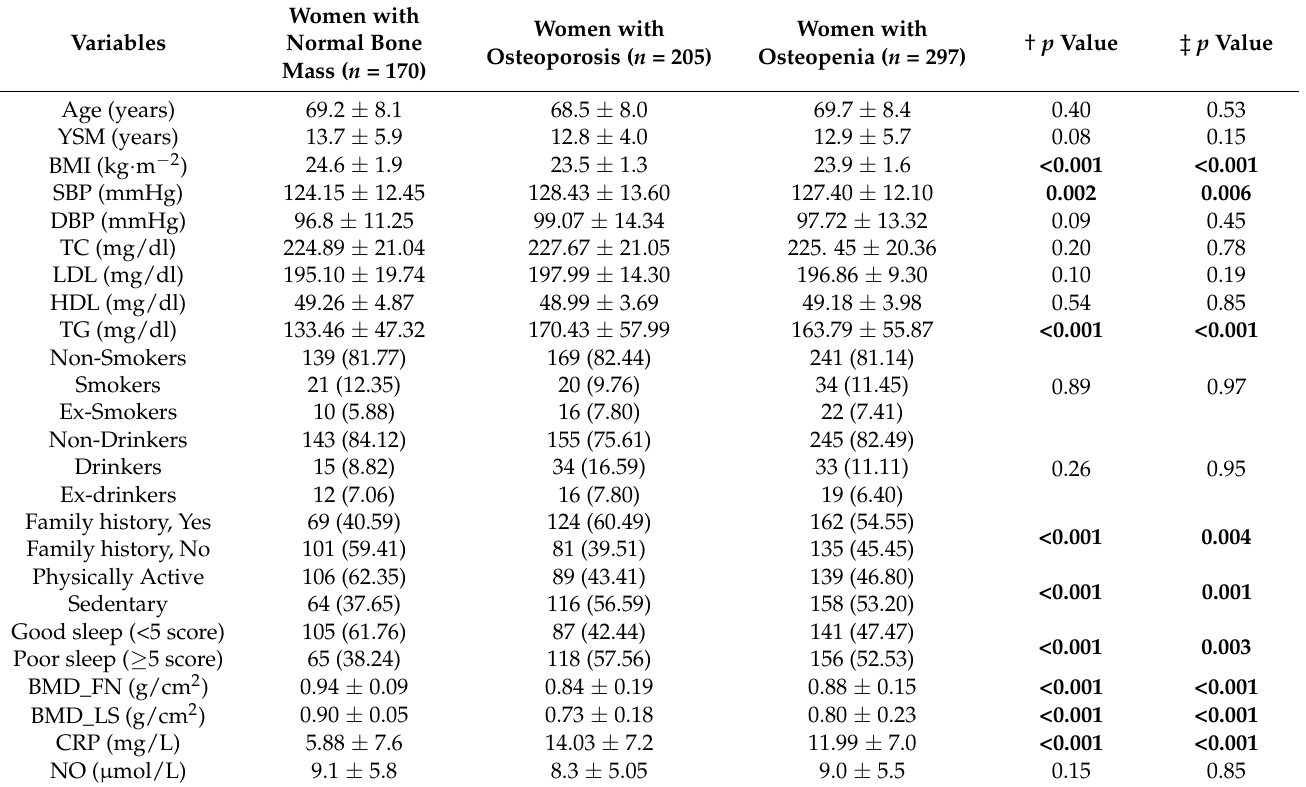
Table 1. General characteristics of the study